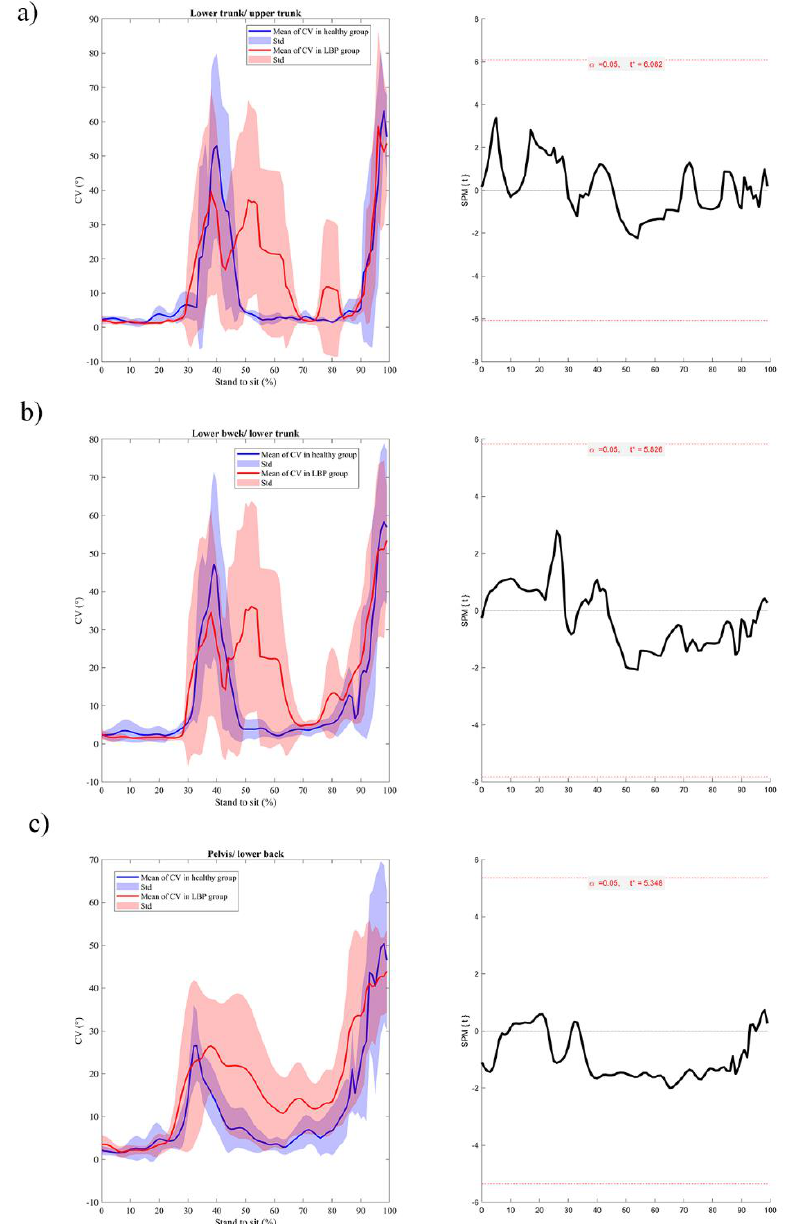
Figure 6. ( a ) LT/UT, ( b ) LB/LT, and ( c ) Pelvis/LB coordination variability (CV) in the sagittal plane, and the results of an independent t -test using the SPM method during stand-to-sit, left side is the mean and standard diviation of CV and right side is the results of SPM analysis. Red dotted line in the SPM results in the critical threshold (t value).